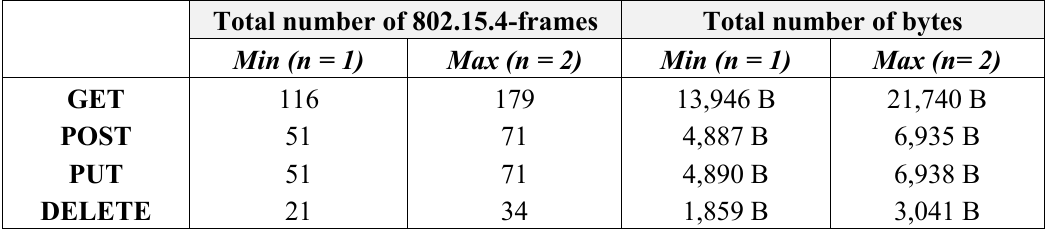
Table 4. Analysis of CoAP on a transaction basis; Blockwise transfer mode activated.